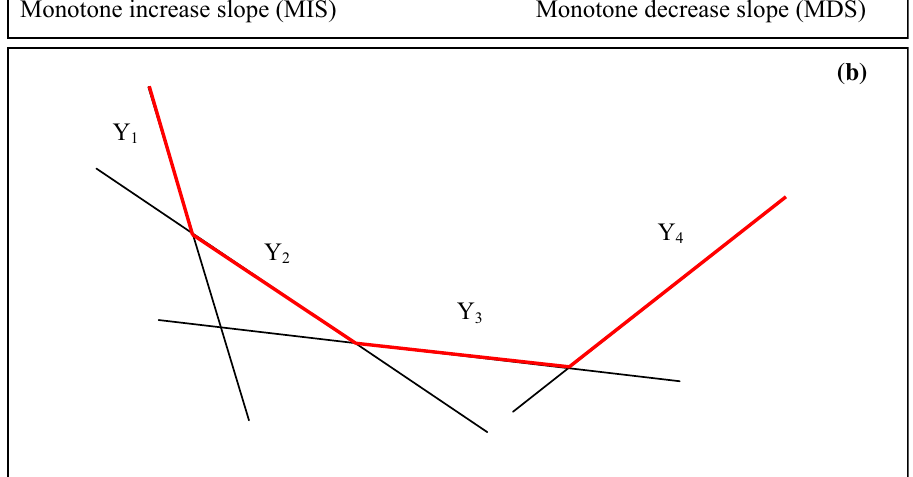
Fig. 1 Schematic diagram of asymptotic matching method. Solid line represents the final model and the dashed lines represent the asymptotes with linear segments: a a series of two segments of Y 1 and Y 2 with the dash-dot lines being the entire relation of Y 1 and Y 2 fitted by using the corresponding exponent m ; b a series of four linear segments of monotone increasing